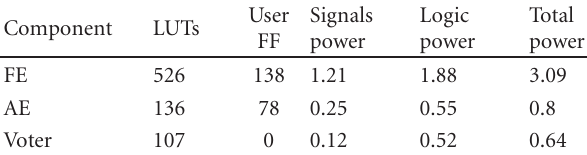
Table 12: XPower analyzer results (power in mWatts).